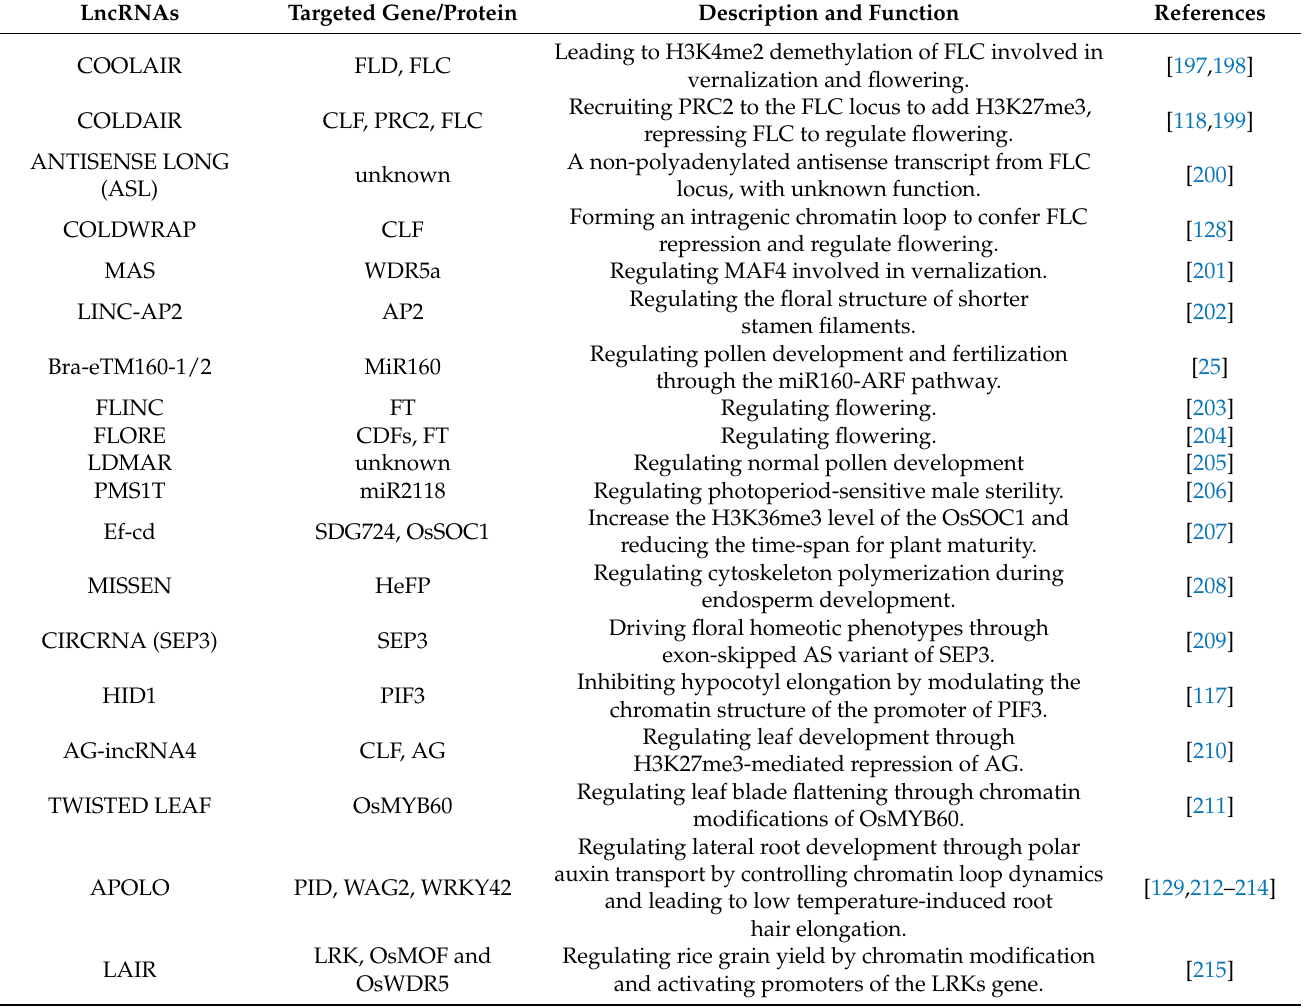
Table 2. List of plant lncRNAs associated with plant